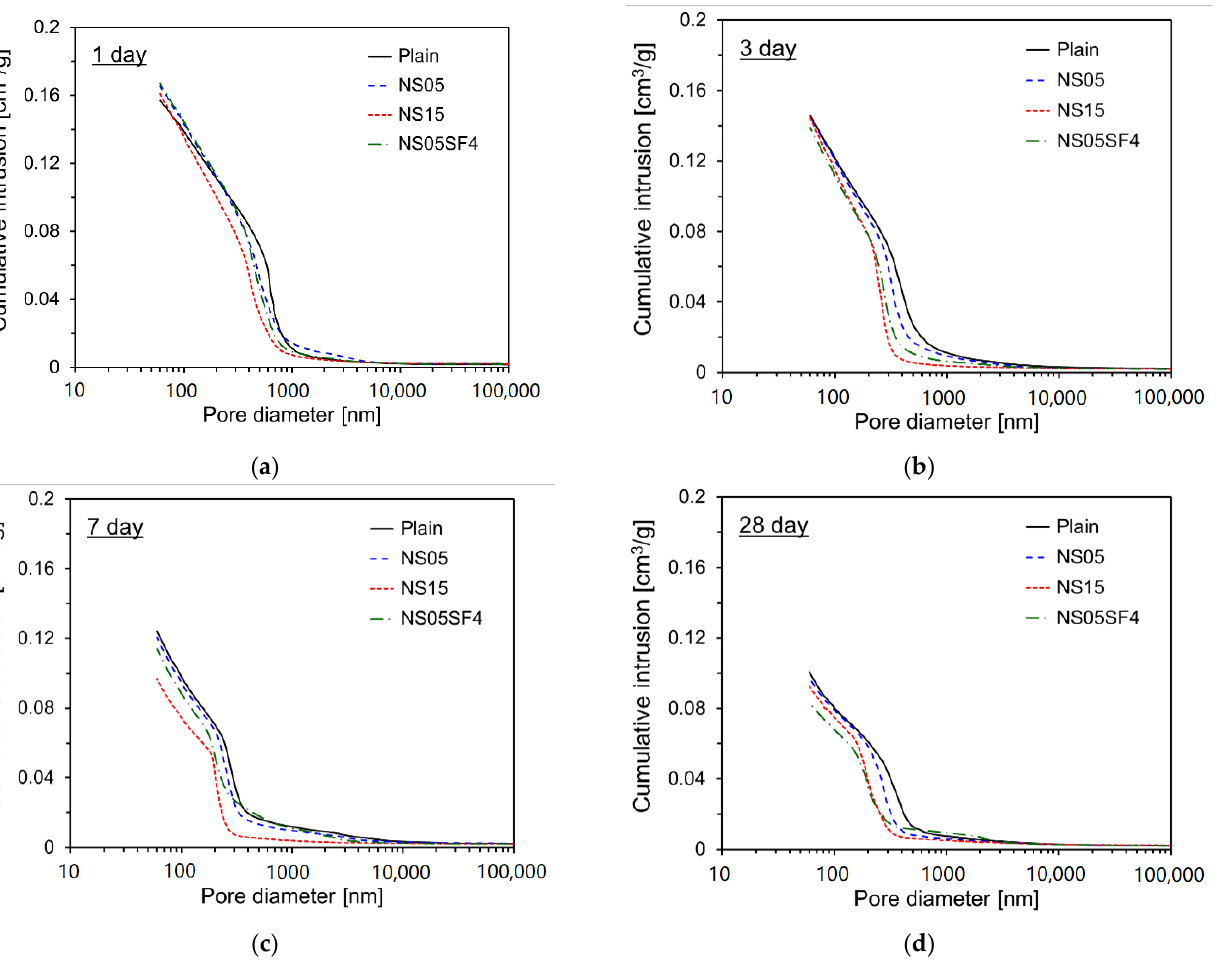
Figure 11. Cumulative intrusions in specimens. ( a ) 1 day; ( b ) 3 days; ( c ) 7 days; ( d ) 28 days.